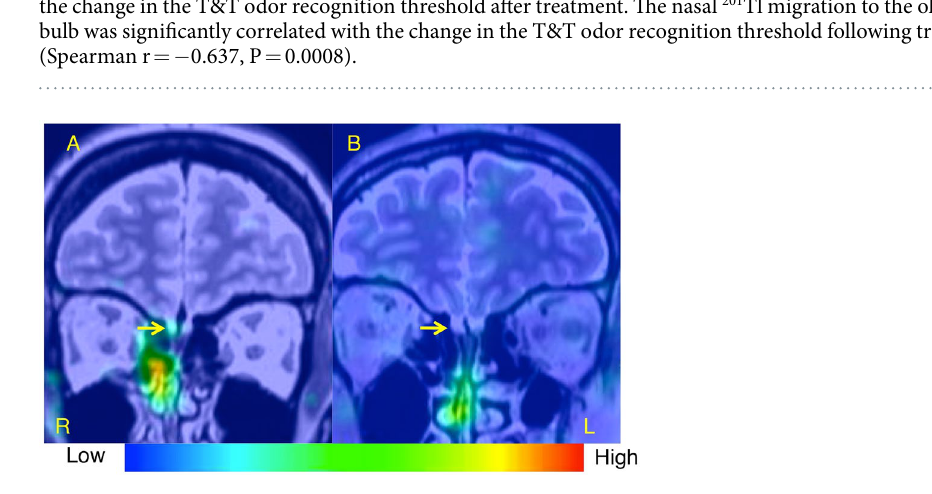
201 Tl migration to the olfactory bulb, suggesting that patients with intact olfactory nerve fibers could be selected using thallium-based imaging for the long-term follow-up of olfactory dysfunction. Intravenous injection of thiamine propyldisulfide (Alinamin) induces the sensation of a garlic-like odor, and Alinamin injection is widely used as one of the subjective olfactory tests in Japan 13 . Nonresponders in the Alinamin test have been previously shown to have poor prognosis in the recovery of olfactory acuity 14 . The Alinamin test is simple but often results in vascular pain; the Alinamin test was not assessed here because five patients refused to undertake the test because of the associated pain. The olfactory bulb volume has been shown to be a predictor of olfactory recovery in patients with postin- fectious and posttraumatic olfactory loss 3 . In the present study, the olfactory bulb volume was not significantly correlated with the duration until recovery of olfactory recognition, although the data for olfactory bulb volume were dichotomized according to a previous study ( < 40 mm 3 vs. ≥ 40 mm 3 ) 3 . The reason for this discrepancy may be that the subjects in this study, but not those in the previous study, suffered from idiopathic olfactory disorder. To evaluate olfactory nerve connectivity in patients with impaired olfaction, assessing the migration of nasally administered 201 Tl to the olfactory bulb is a useful and safe method. None of the subjects examined here experi- enced major side effects following the nasal administration of 201 Tl, perhaps due to the small dose of administered 201 Tl. The absorbed doses of 201 Tl were estimated as 0.59 mGy in the lens and 0.067 mGy in the brain after the nasal administration of 22 MBq 201 Tl by applying the MIRD formula 7, 15 . Thus far, no serious side effects have been reported in subjects after olfacto-scintigraphy. Furthermore, because the facial bone surrounds the nasal turbinates, acute radiation effects to the neighboring organs, such as the lens and brain, may be tolerable.